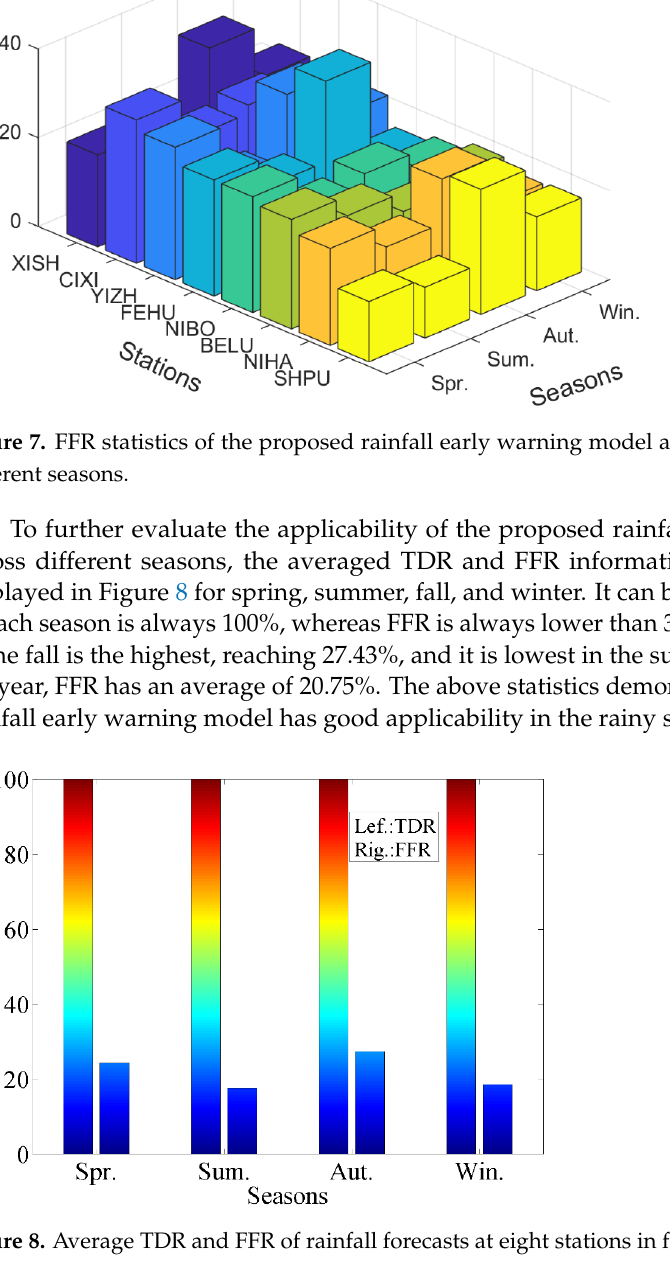
Figure 6. Correlation between multiple meteorological parameters (PWV, P, T, ZTD) and rainfall, where ( a , b ) are the results at FEHU and NIHA stations